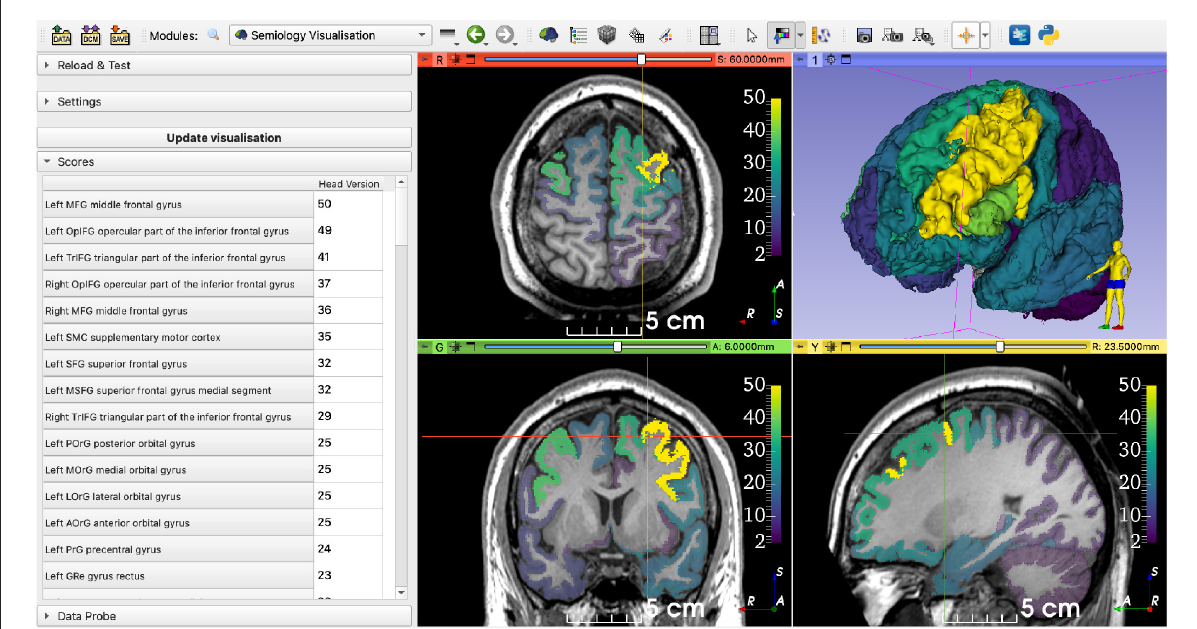
FIGURE7 Querying the database using data from a retrospective patient case. The selected semiology term was Head version (right) , and the dominant hemisphere was Left . The regions with highest numbers of datapoints concentrate around the left frontal lobe (represented on the right side of the axial and coronal views).